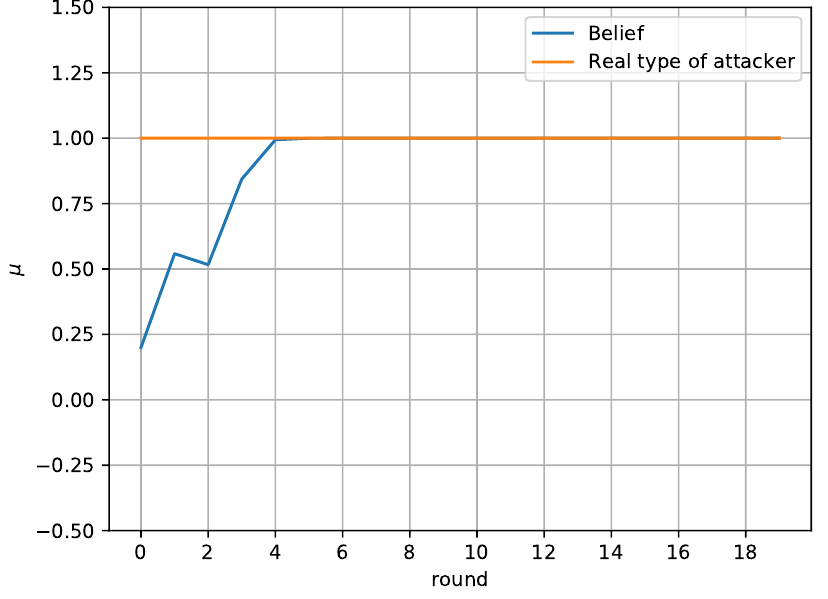
Figure 7. Defender’s belief in the repeated